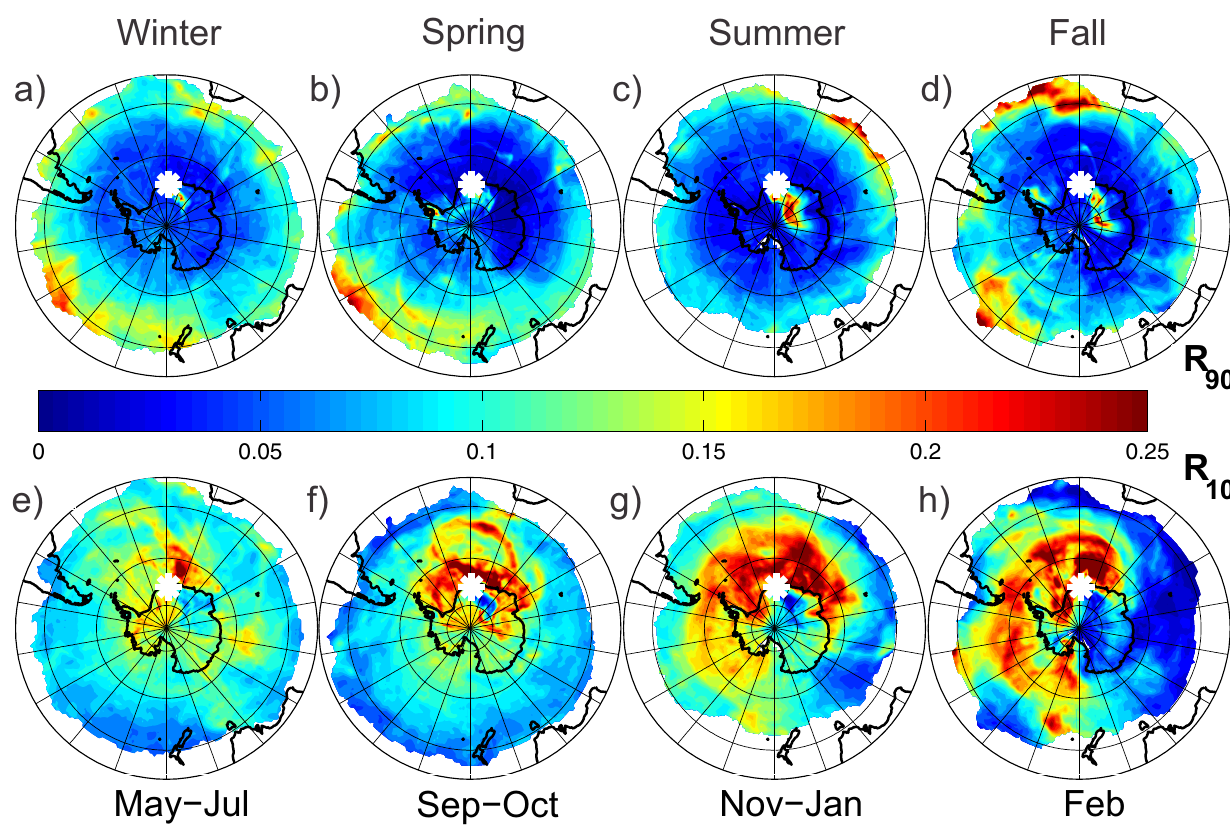
Figure 6. Fields of R 90 (top four panels) and R 10 (bottom four panels) for ozone measurements at TRS from 2007 through June 2010. The location of TRS is marked with a white asterisk. Areas where S T is below the threshold are plotted